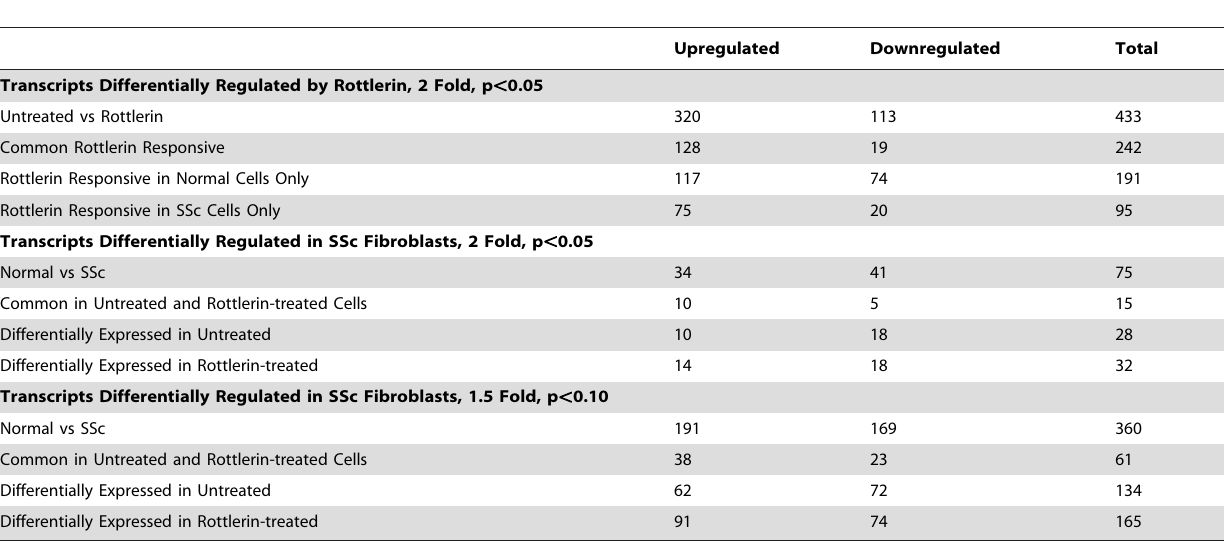
Table 1. Number of differentially expressed transcripts in control fibroblasts vs rottlerin exposed human dermal fibroblasts derived from normal or SSc patients at different statistical criteria using Volcano plot as a